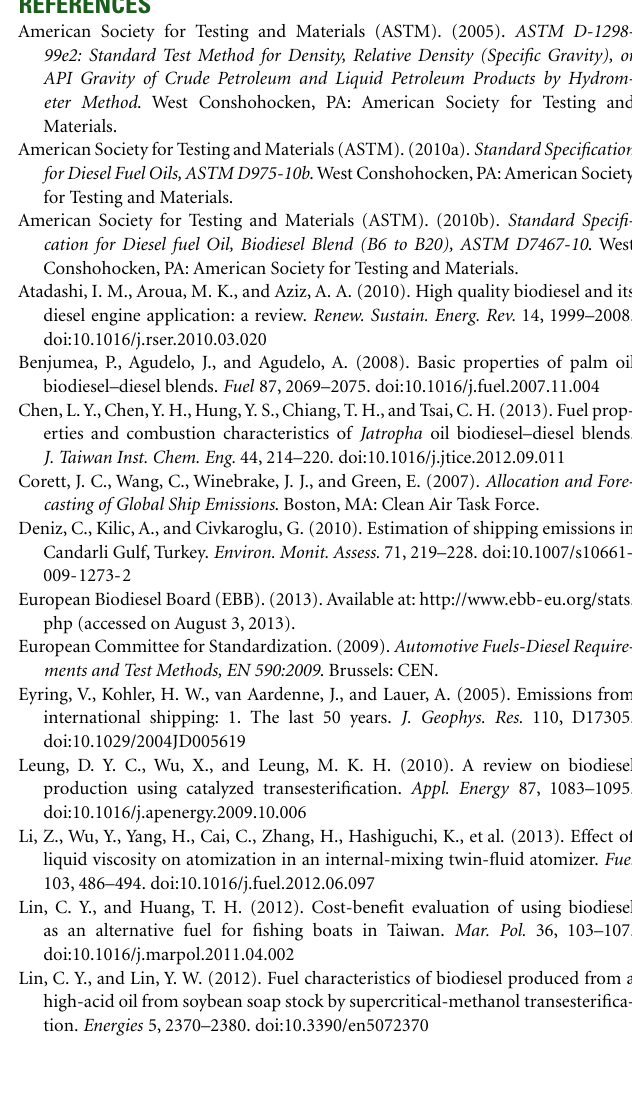
The sulfur contents of fuels B and A decreased by as much as 37 and 33%, respectively, by blending with 25 wt.%